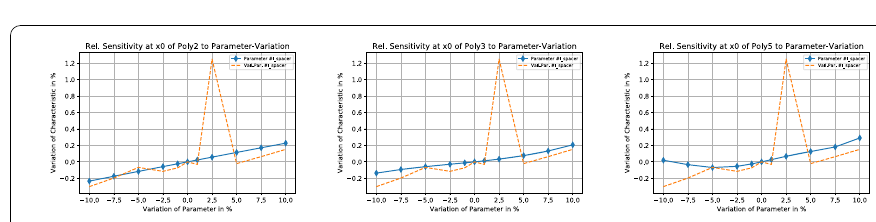
Including the interactions of combined influences in (cid:2) x . The vertical range is calculated by an optimization routine with variation limits within a ± 1%-range (resp. ± 5%), searching for minimum/maximum deviation from the initial value. Both plots differ only in